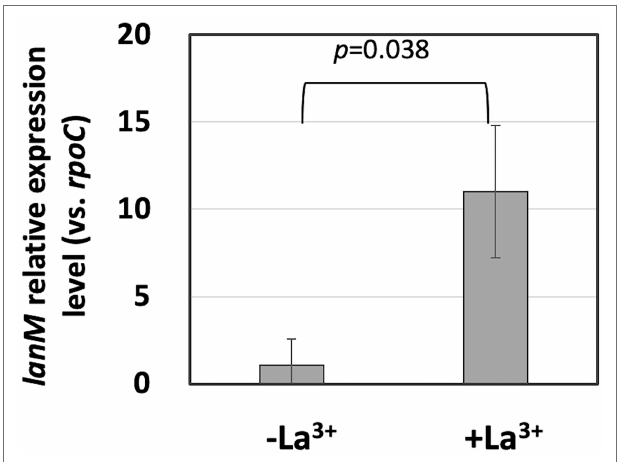
FIGURE 1 | lanM expression level in Methylobacterium aquaticum strain 22A grown on methanol in the presence/absence of 30 μ M La 3+ , quantified by qPCR. lanM expression level is shown as the relative expression level compared to that of rpoC as a reference. Data were analyzed with Student’s t